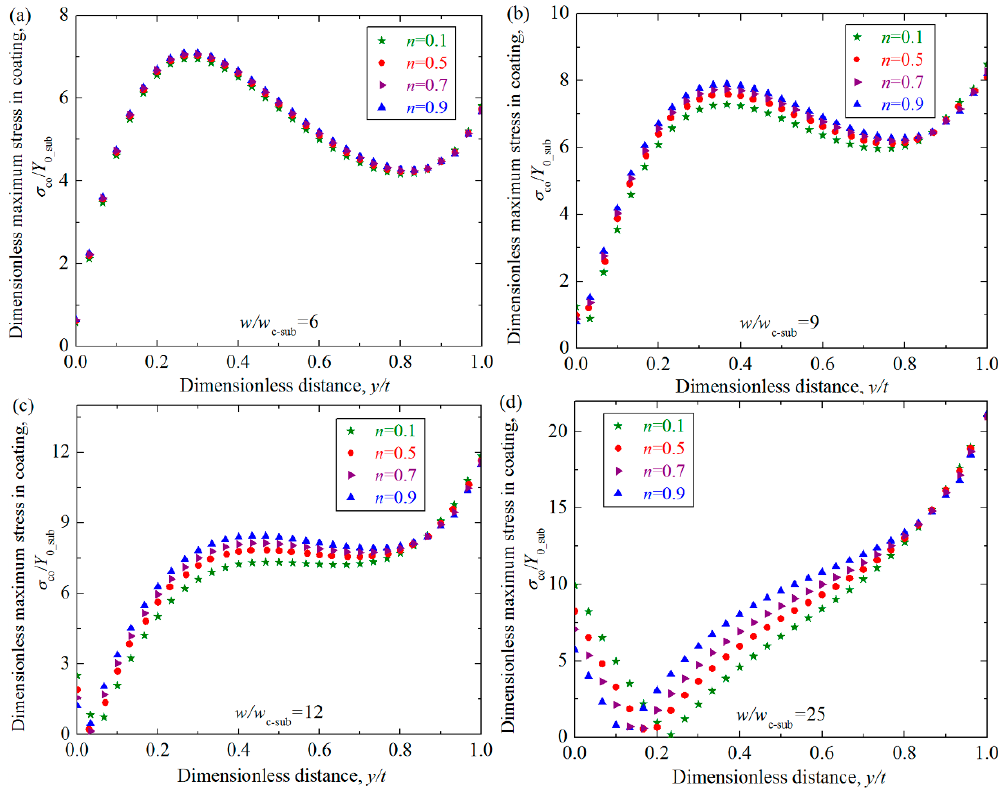
Figure 9. The distribution of the dimensionless equivalent von Mises stresses σ co /Y 0_sub in the coating along the axis of symmetry at the different interferences near the inflection point w / w c_sub = 6, 9, 12, 25 for some typical cases where dimensionless coating thickness t/R = 0.01, Young’s modulus ratios E co /E su = 4 at selected hardening exponents of the substrate n = 0.1, 0.5, 0.7, 0.9.